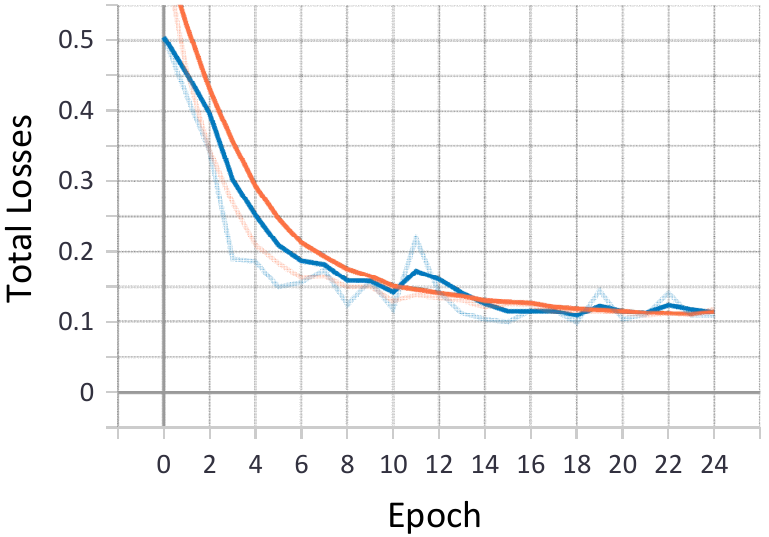
Figure 10. Total training and validation losses for Multitask Data Fusion based Neural Network.